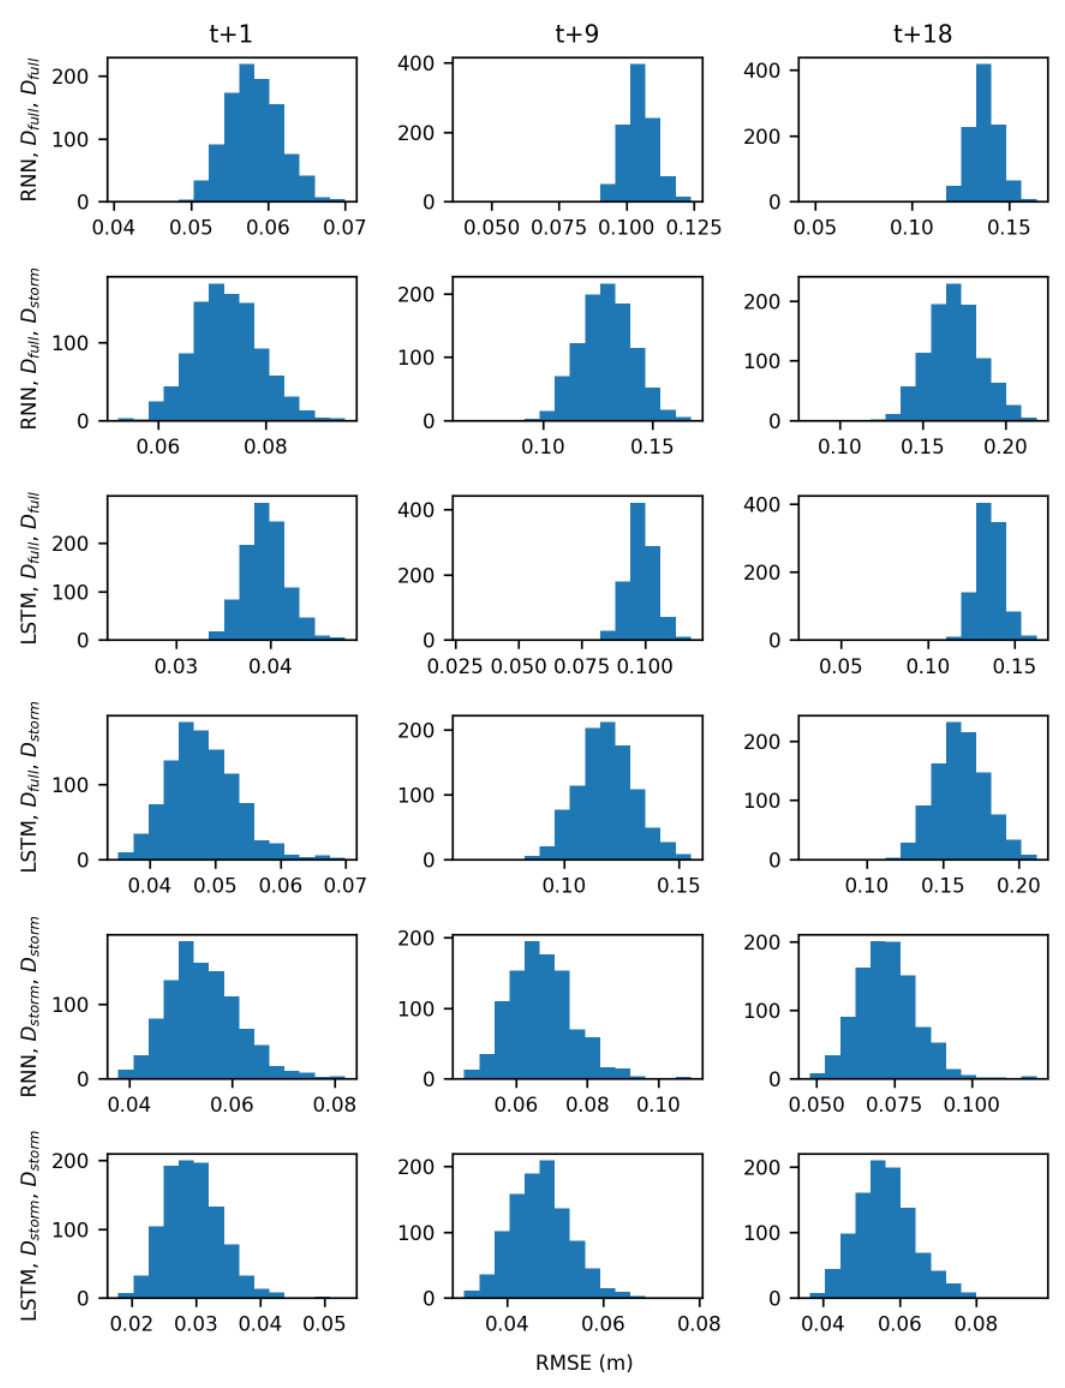
Figure A5. RMSE distributions for GW5 using observed data. Columns represent the forecast horizons t + 1, t + 9, and t + 18. Rows are specified as model type, training data, and testing data.